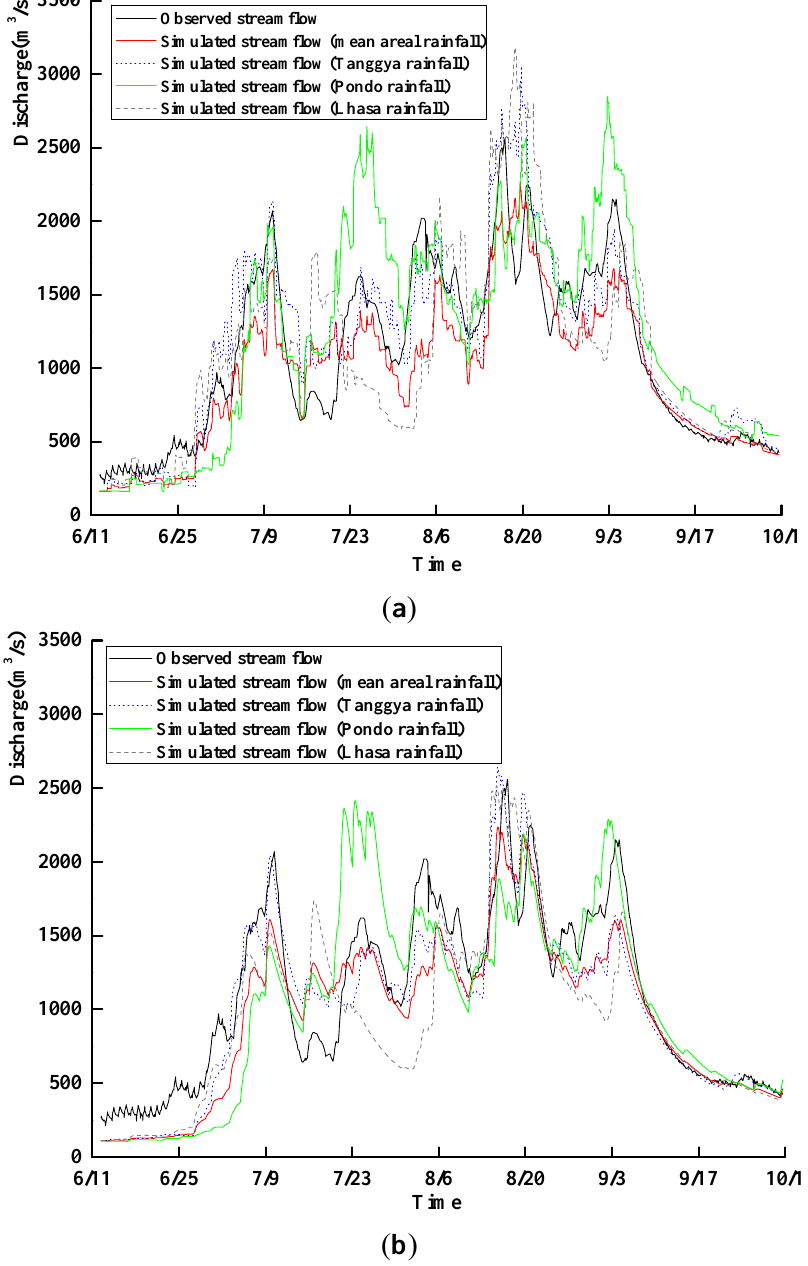
Figure 3. Observed and simulated hourly stream flow at Lhasa in 1998 by using ( a ) Routing 1; and ( b ) Routing 2 based on the different rainfall